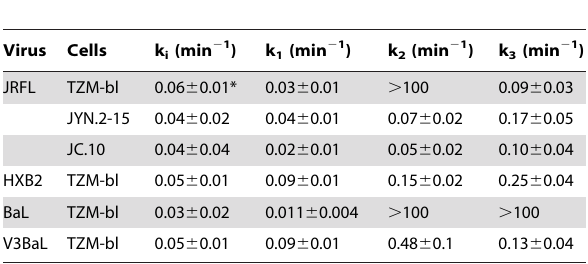
Table 2. HIV-1 sensitivity to inhibition by AD101 and